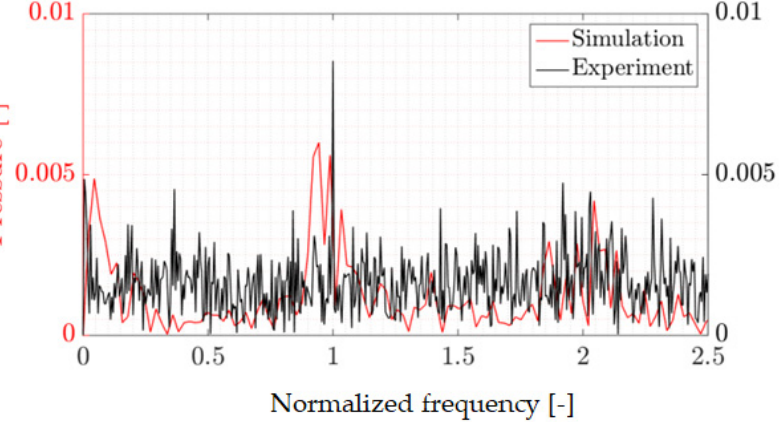
Figure 14. Amplitude spectrum of the pressure at P-PS-6 (pressure side, near the trailing edge, closer to the hub). Two vertical axes are used; numerical results—red, experimental results—black.